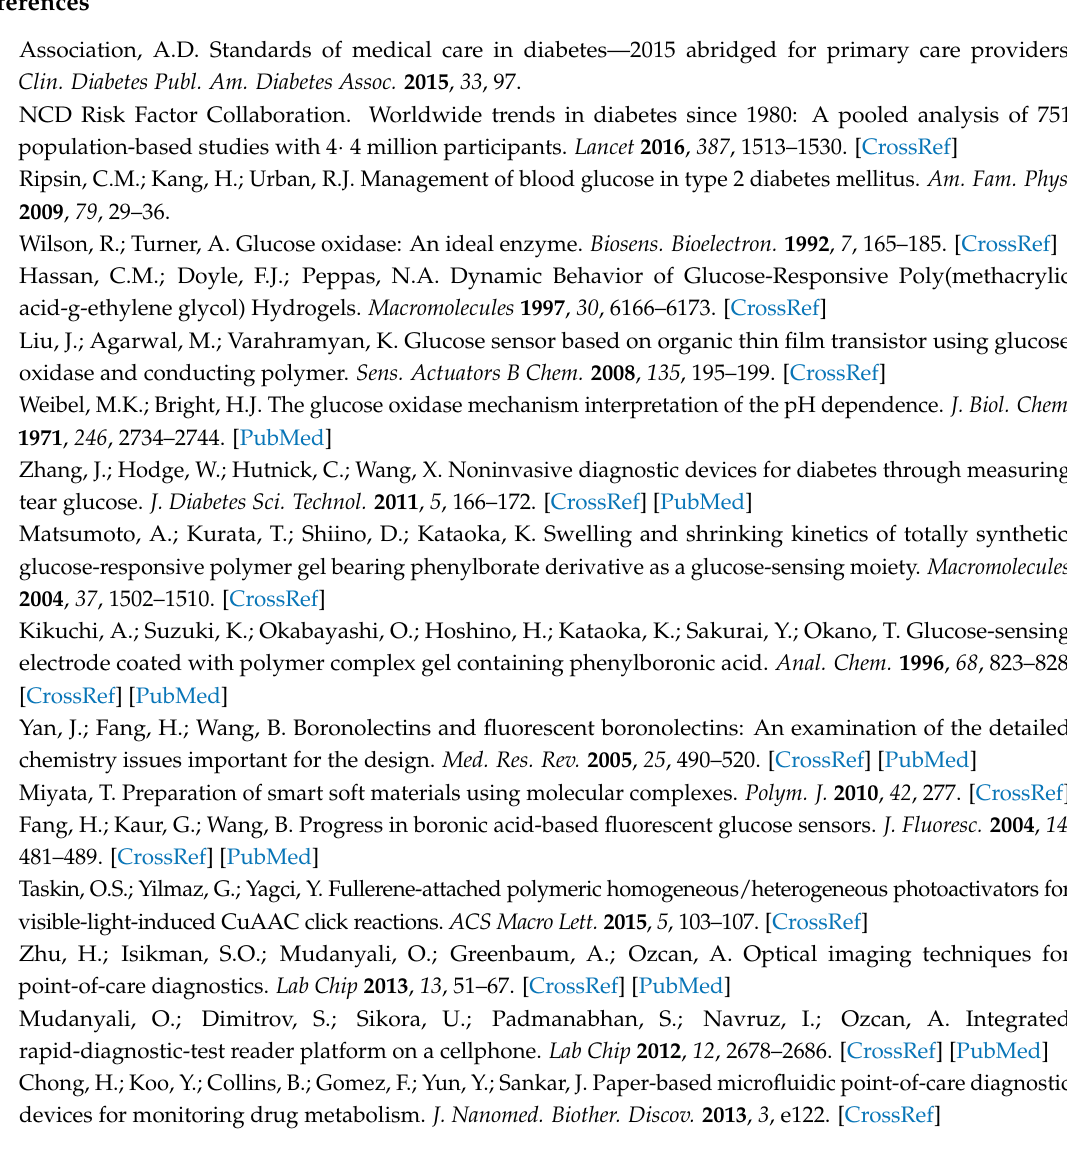
s1, Figure S1. Prototype: Device of the detection and emission, Figure S2. Final device of the detection and emission, Figure S3. Illustration of detection process before and after the image processing steps and Figure S4. The cytotoxicity of PBA-based pHEMA contact lens against